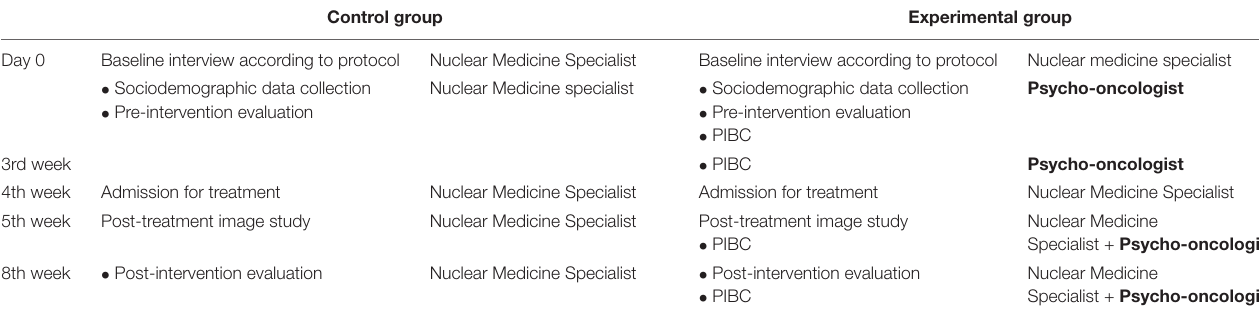
TABLE 1 | Intervention itinerary for control group (CG) and experimental group (EG)